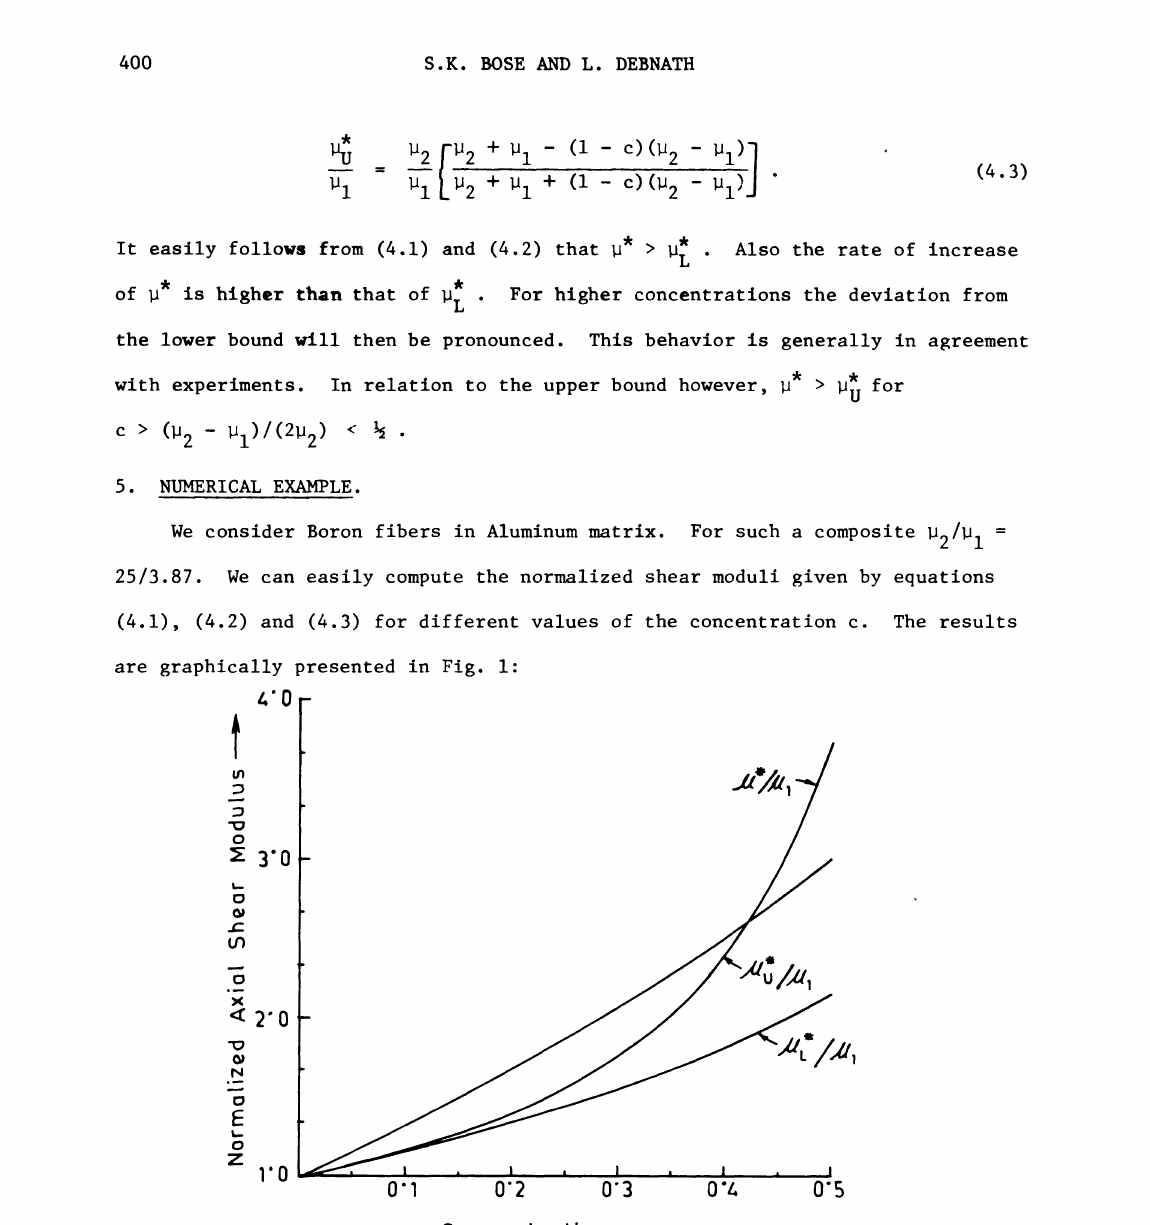
Fig. I: Concent’otion